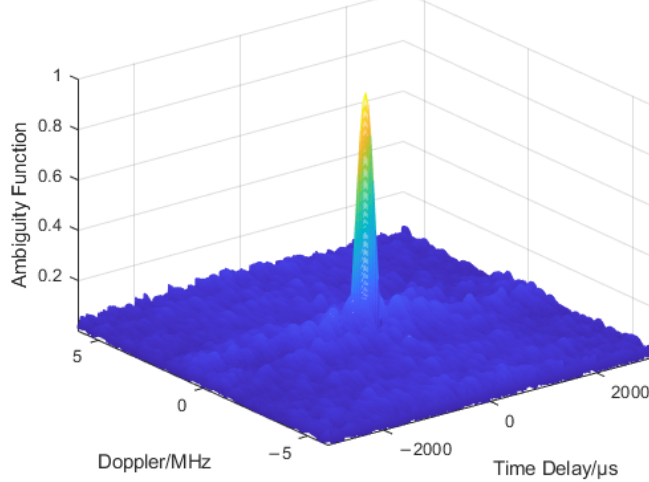
Figure 8. Ambiguity Function of the Joint coding